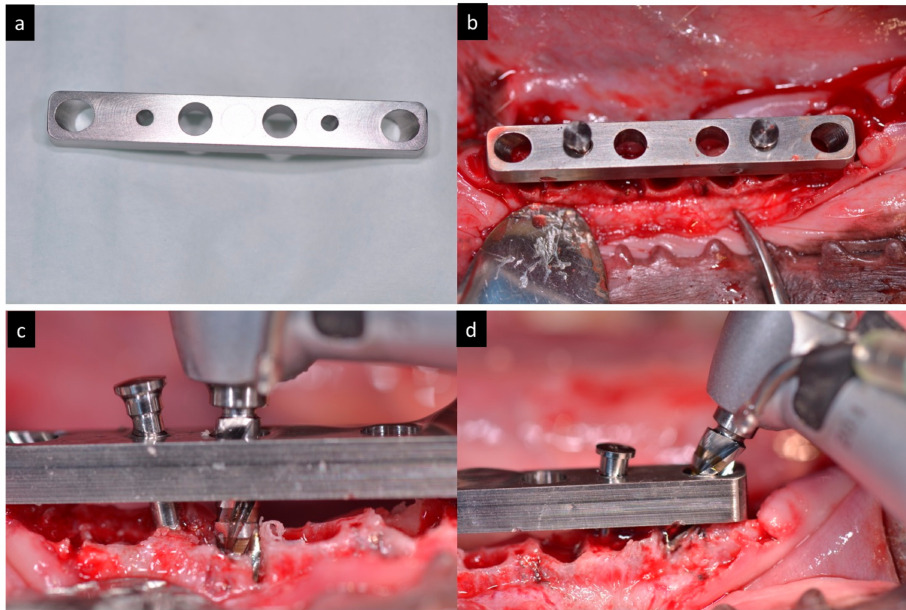
Figure 2. ( a ) Aspect of the surgical guide. ( b ) Surgical guide fixed in the mandible. ( c ) Drilling trough the surgical guide in axial direction. ( d ) Drilling trough the surgical guide in tilted direction.